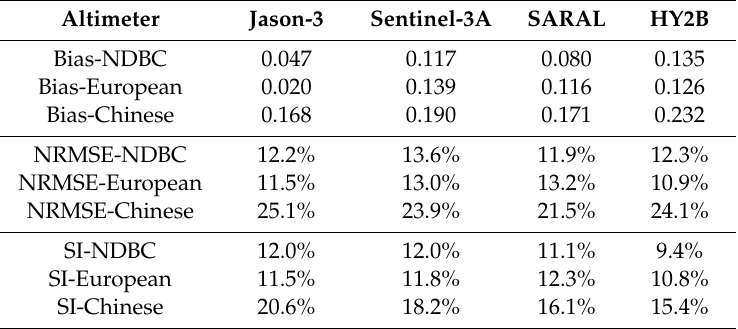
Table 1. Validations of altimeter SWHs against the buoy